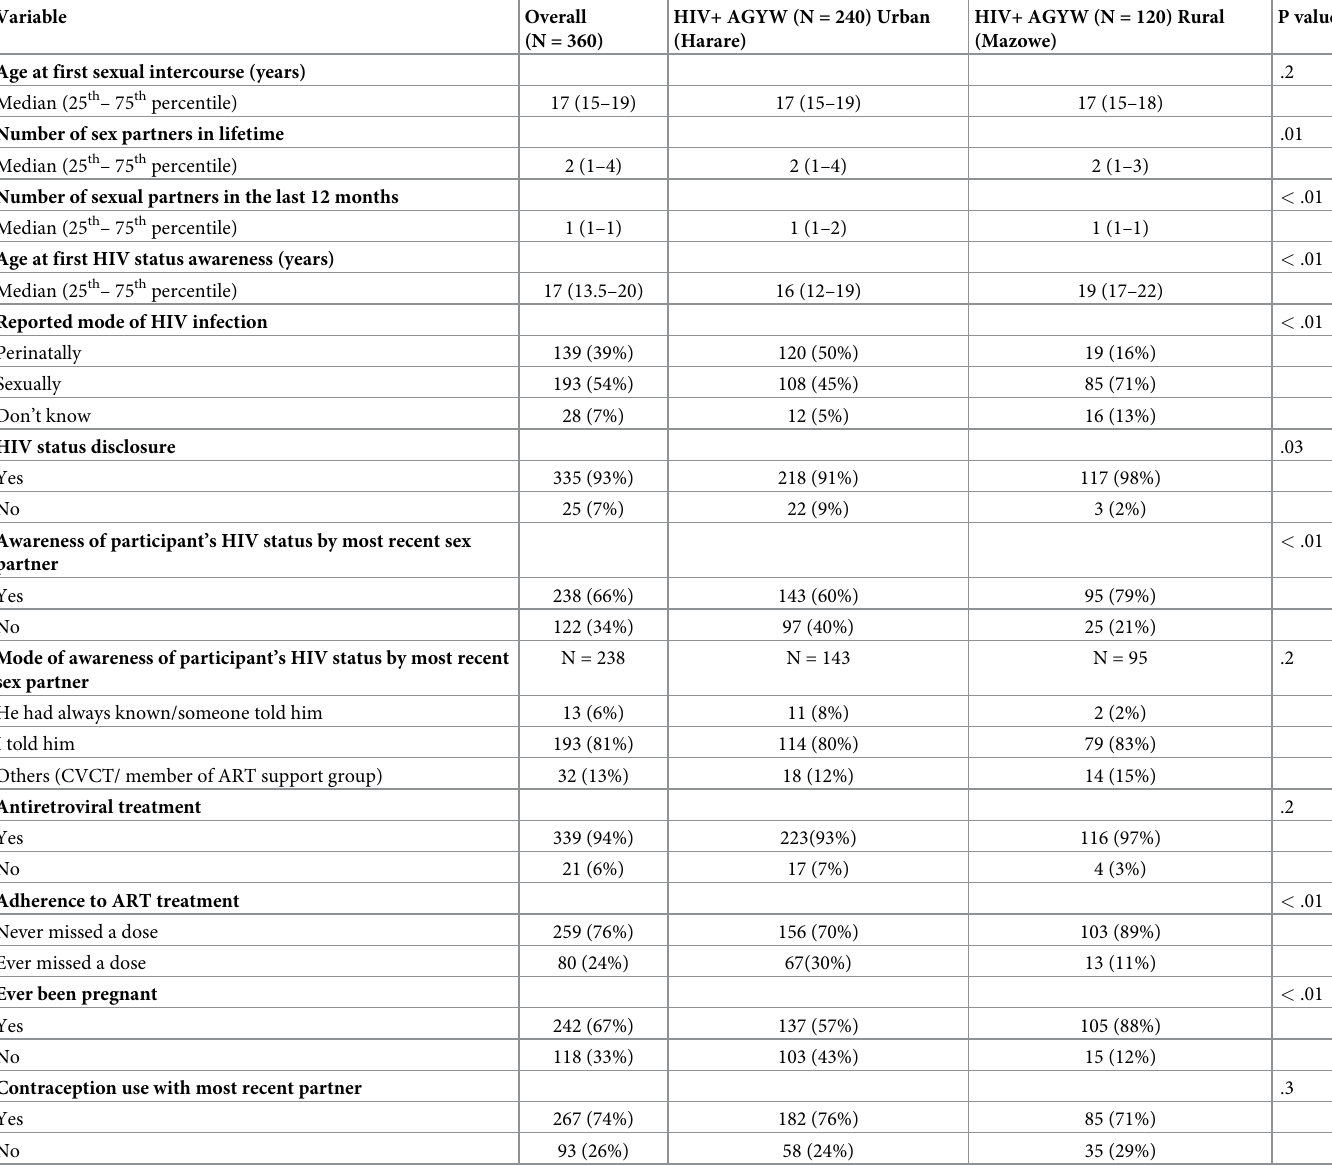
Table 2. HIV-related and sexual and reproductive characteristics of HIV-positive adolescent girls and young women by